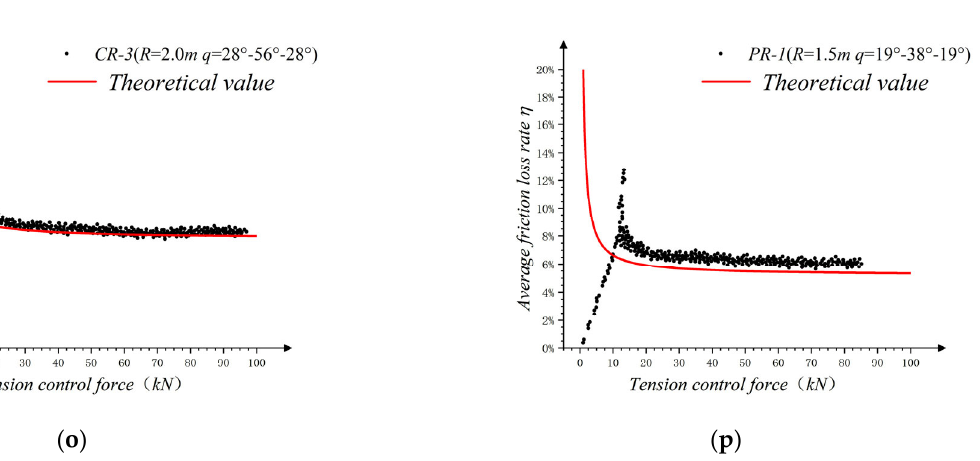
Figure 14. Comparison of theoretical value and test value: ( a ) CL ‐ 1; ( b ) CL ‐ 2; ( c ) CL ‐ 3; ( d ) CL ‐ 4; ( e ) ML ‐ 1; ( f ) ML ‐ 2; ( g ) ML ‐ 3; ( h ) ML ‐ 4; ( i ) PL ‐ 1; ( j ) PL ‐ 2; ( k ) PL ‐ 3; ( l ) PL ‐ 4; ( m ) CR ‐ 1; ( n ) CR ‐ 2; ( o ) CR ‐